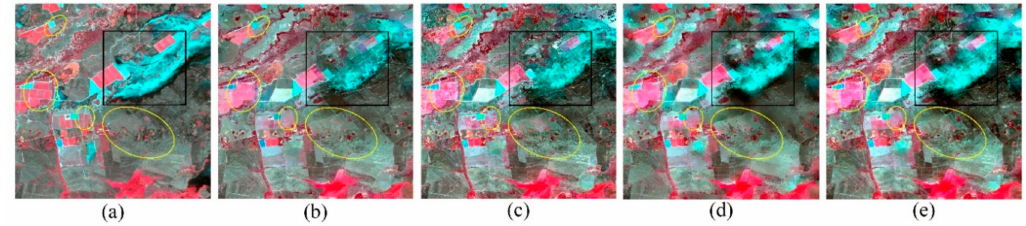
Figure 7. Visual comparison of Landsat-like images predicted by STARFM, STRUM, FSDAF, and EFSDAF in dataset 2 (flood). From left to right, green-red-NIR (standard false color) composites of ( a ) true Landsat image of 12 December 2004; ( b – e ) predicted images of 12 December 2004 by STARFM, STRUM, FSDAF, and EFSDAF, respectively. (Figure 7 presents the predicted Landsat-like images of 12 December 2004 by four fusion methods in the abrupt change area, and the yellow elliptical circles of Figure 7 represent the di ff erences of the four fusion methods. The zoom-in black square areas marked in Figure 7 are used to more clearly compare the fusion results by the four methods in the land cover change area (Figure